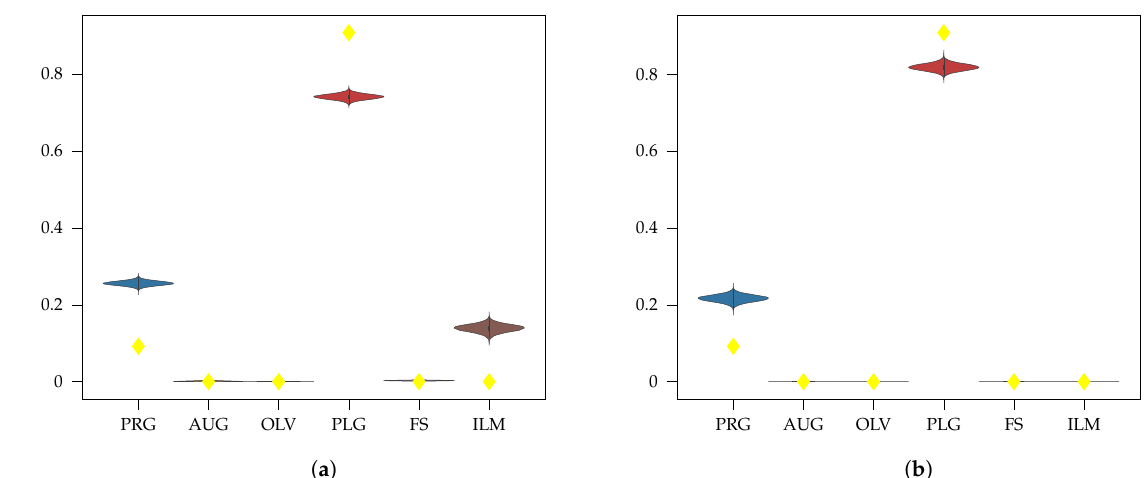
Figure 15. Violin plots for mix 0 of the fresh laboratory mixtures. Yellow diamonds mark the theoretical abundances that were used for mixing the endmembers. ( a ) Without prior; ( b ) TiO 2 prior.